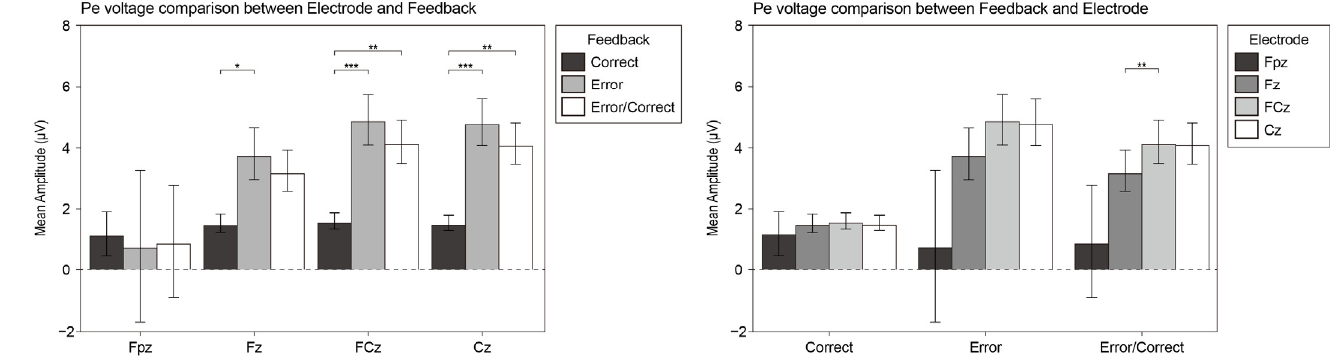
Figure 10. The bar plots of the interaction effect of Pe. Values plotted are means ± standard errors. Stars indicate significance levels: * = p < 0.05, ** = p < 0.01, *** = p < 0.001.